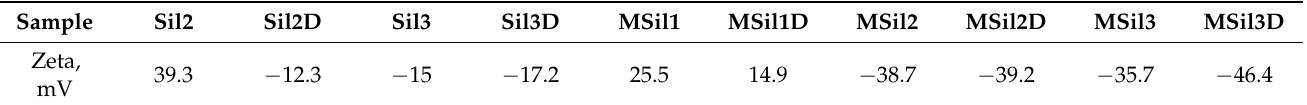
Table 4. Zeta potential values for the silica materials before and after Dox encapsulation (the later samples are denoted with “D”).